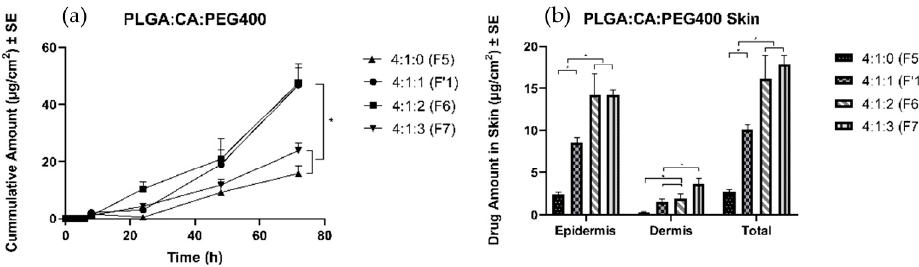
Figure 3. Permeation profiles of TS through porcine ear skin to study the effects of plasticizer. The group is representative of the ratio between PLGA:CA:PEG 400. ( a ) Cumulative amount ( b ) Average amount in the epidermis, dermis, and total skin. Table 3. Amounts of TS extracted after 72 h in the epidermis and dermis and the total amount of TS for all